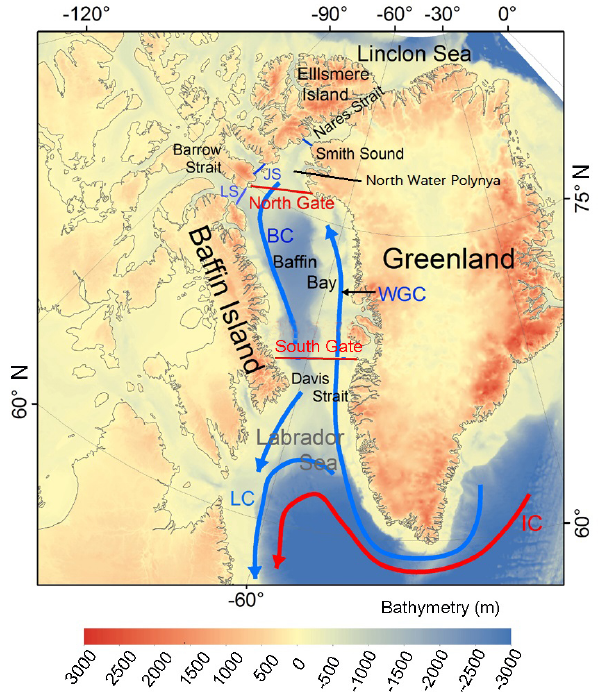
Figure 1. The mean circulation pattern in Baffin Bay (blue and red arrows) and the locations of the key fluxgates to assess sea ice area flux through the bay. The West Greenland Current (WGC), Baffin Current (BC), and Labrador Current (LC) are marked with blue ar- rows. The Iriminger Current (IC) is represented by the red arrow. The key fluxgates through which sea ice floats into the bay includes Nares Strait, Jones Sound (JS), and Lancaster Sound (LS). Area flux through a defined northern gate together with the LS flux is used to quantify the sea ice area inflow to the bay. The outflow fields are depicted using flux via the southern